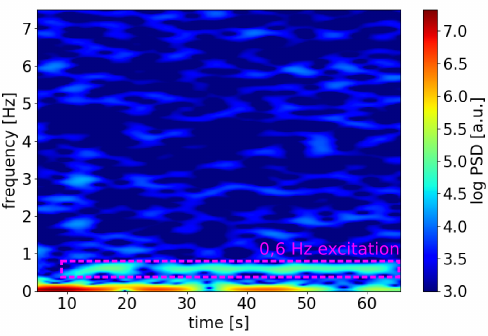
Figure 10. Spectrogram calculated from C-OTDR signal in single sensor segment within the power cable at a sensing distance of more than 55 km . The excitation frequency f = 0.6 Hz is clearly